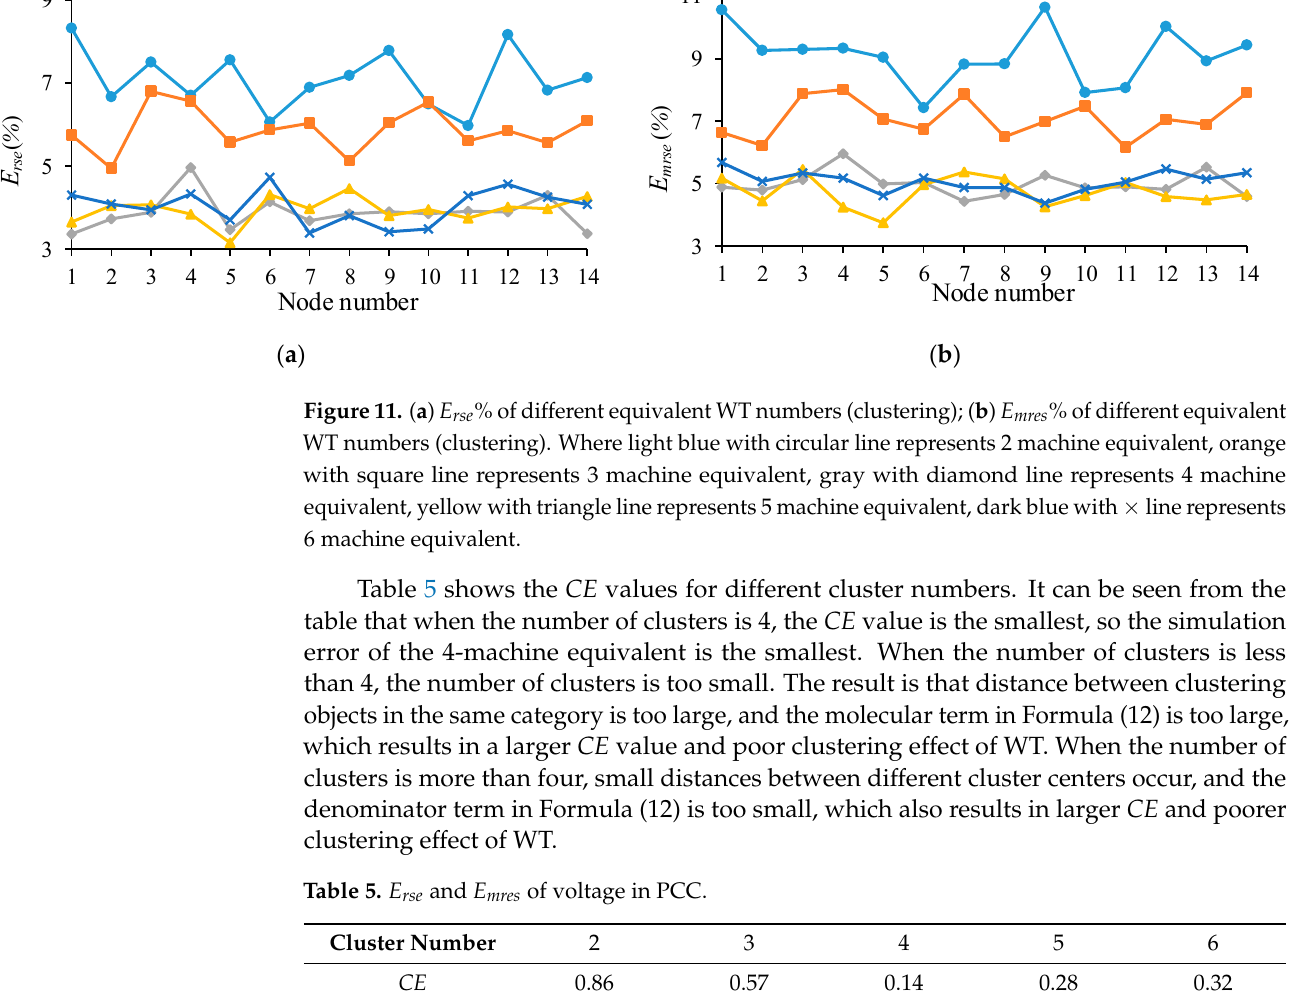
Figure 10. Voltage curves in PCC of different models.